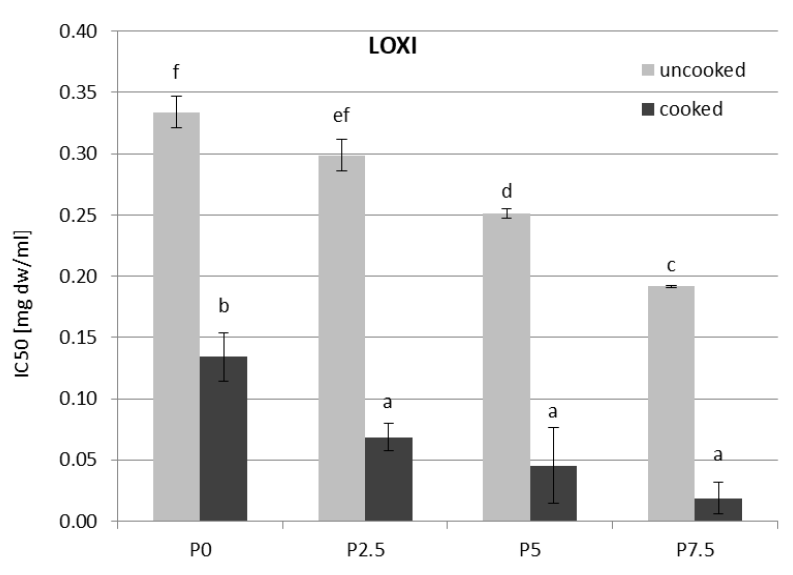
Figure 3. Lipoxygenase inhibitory activity (LOXI) of extracts from uncooked and cooked pastas fortified with onion skin powder. P0—control pasta; P2.5–7.5 pastas fortified with 2.5–7.5% ( m / m ) of onion skin powder. Different letters indicate significant difference ( p < 0.05).